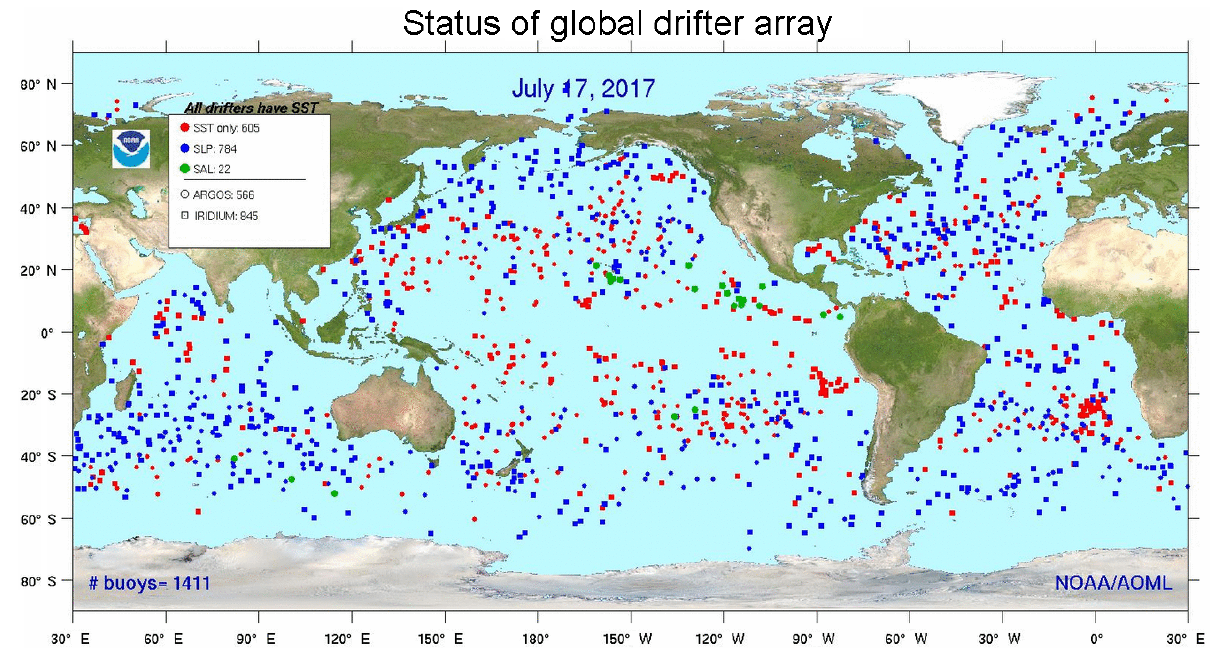
Figure 1. Current distribution of the global drifter array. Map regularly update by NOAA at http://www.aoml.noaa.gov/phod/dac/index.php. Colors indicate additional sensors carried by drifters.